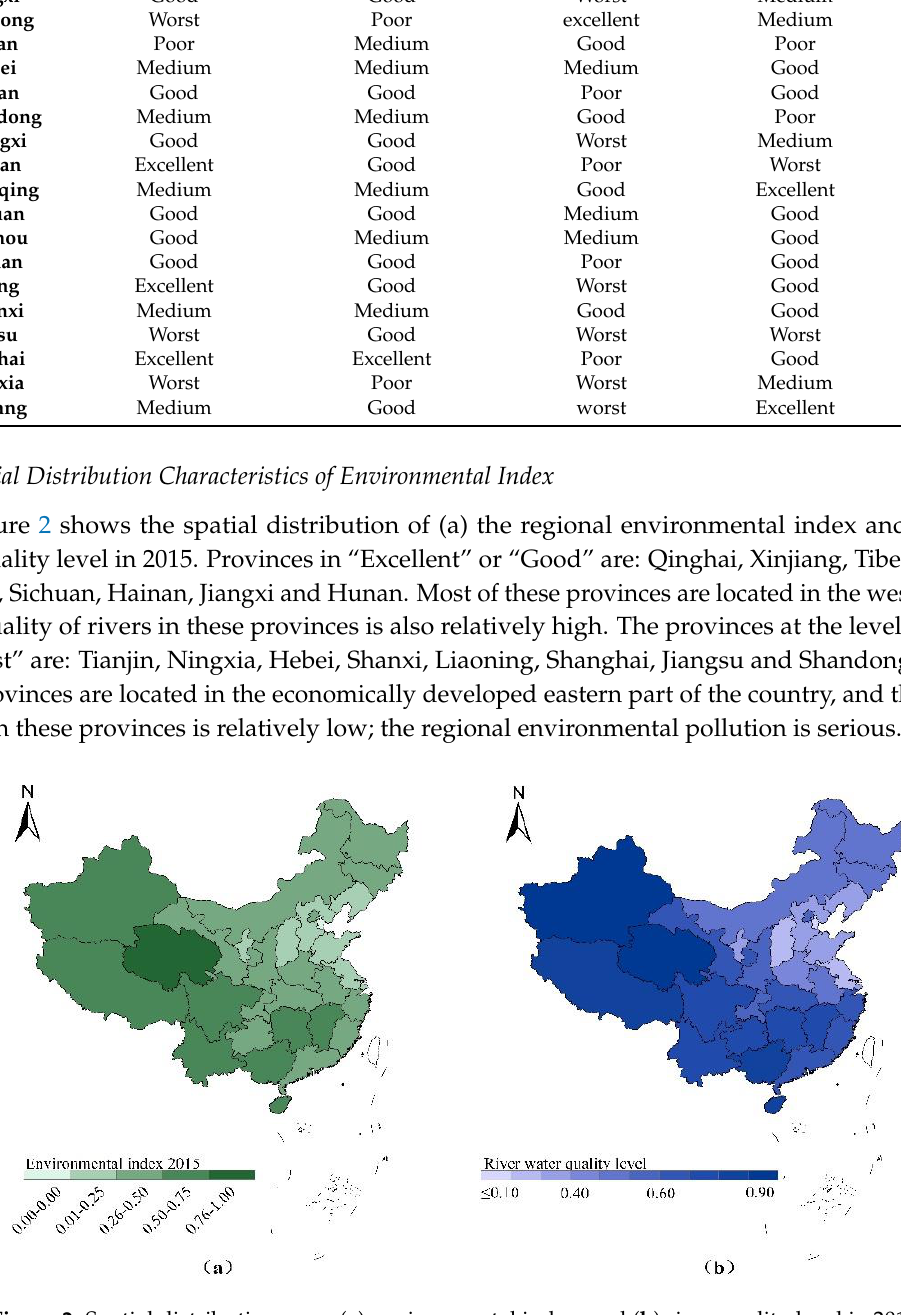
Figure 2. Spatial distribution map: ( a ) environmental index, and ( b ) river quality level in 2015.